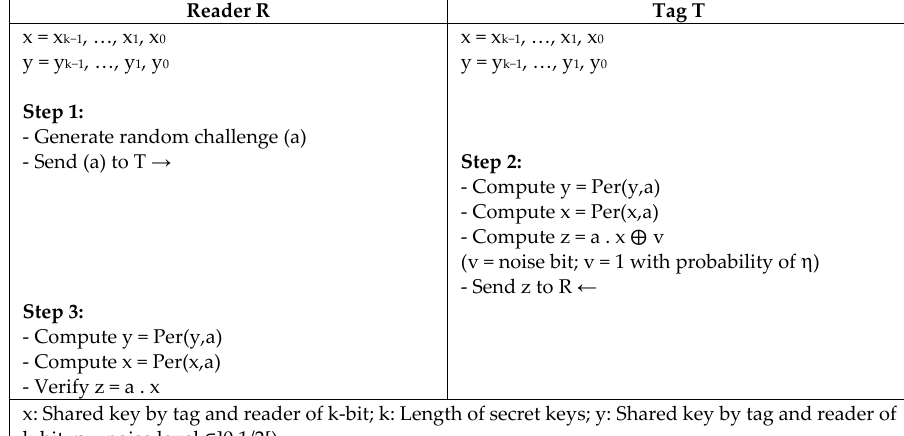
Figure 27. A Variant of HB Protocol Based on Permutation Function (HBPER) by Ouaskou et al.